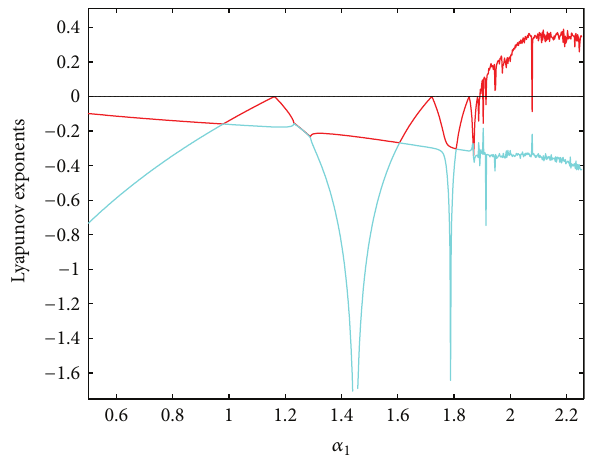
Figure 3: The corresponding Lyapunov exponents diagram with ∈ (0.5,2.2622] and 𝛼 𝛼 1